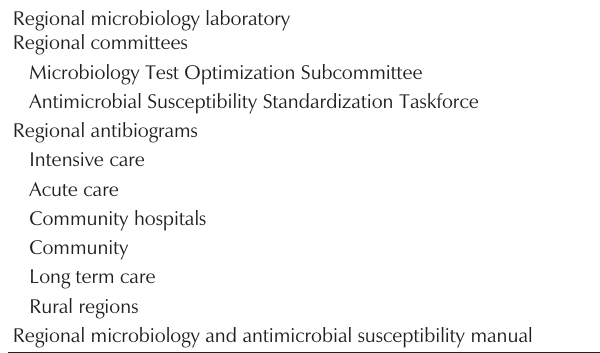
Microbiology laboratory services’ antimicrobial utilization intiatives in the Capital Health region of